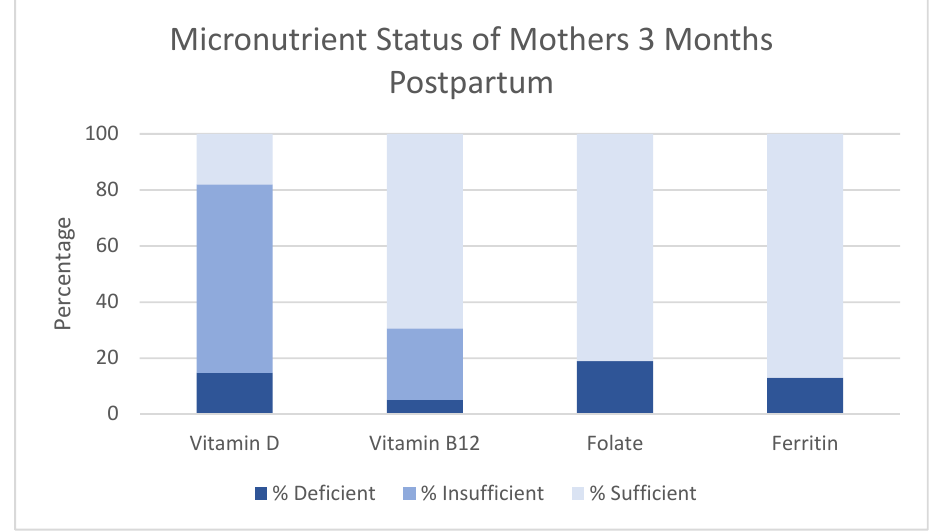
Figure 2. Micronutrient status of mothers three months postpartum. Y-axis indicates percentage. X-axis indicates micronutrient.